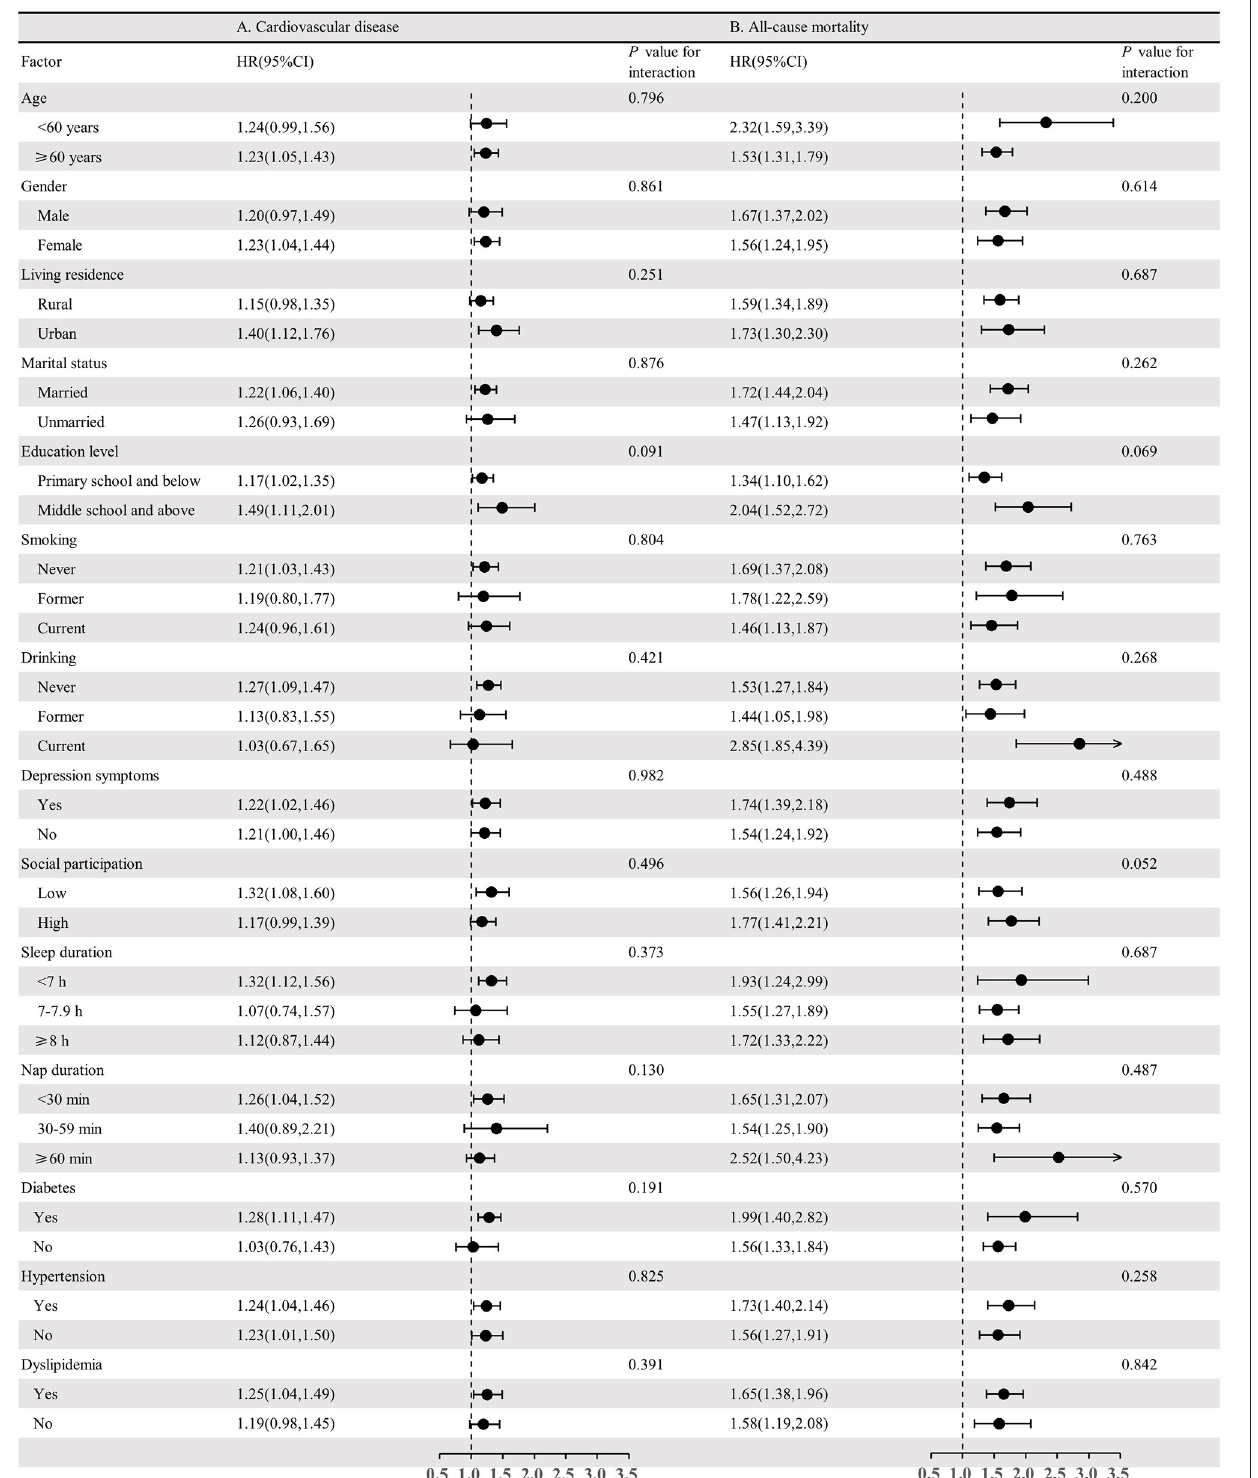
Frontiers in Public Health |